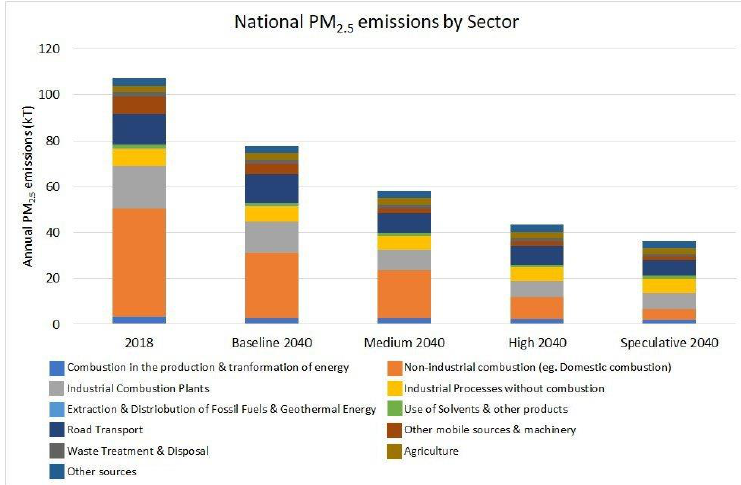
Figure 5. The reduction in emissions in different SNAP sectors is clear for scenarios in 2040, relative to 2018, with progressively greater reductions with higher ambition.